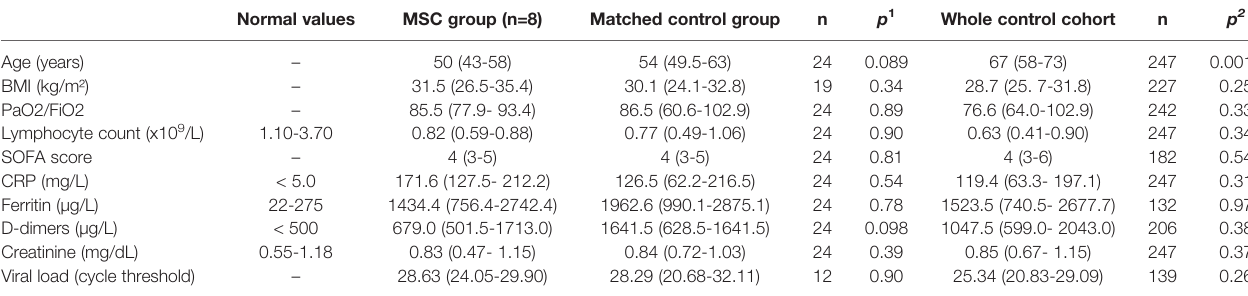
TABLE 1 | Patient baseline